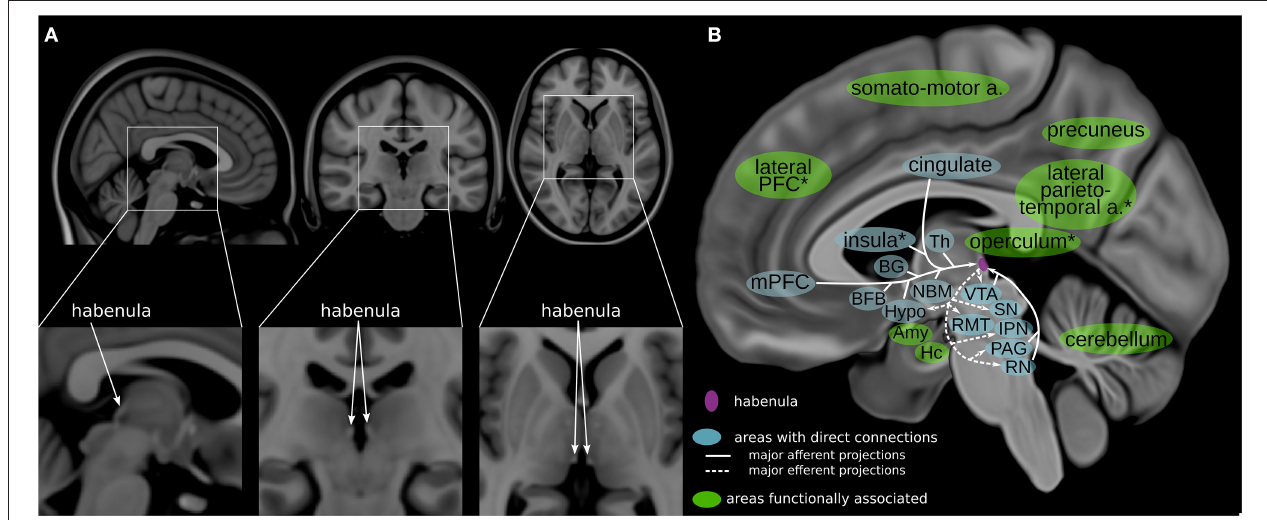
FIGURE 1 | Habenula anatomy and connections. (A) The human habenula illustrated in orthogonal slices using the MNI template brain (MNI152b) (16). (B) Highlighting regions connected with the habenula (17–20) illustrated using a medial view of a high-resolution, high contrast template (21). The habenula is highlighted in purple. Areas with direct connections to the habenula are highlighted in blue; areas that are functionally associated with the habenula are highlighted in green. a, areas; Amy, amygdala; BFB, basal forebrain; BG, basal ganglia; Hc, hippocampus; Hypo, hypothalamus; IPN, interpeduncular nucleus; mPFC, medial prefrontal cortex; NBM, nucleus basalis of Meynert; PAG, periaqueductal gray; PFC, prefrontal cortex; RMT, rostromedial tegmental nucleus; RN, raphe nuclei; SN, substantia nigra; Th, thalamus; VTA, ventral tegmental area; *approximate/example position of the